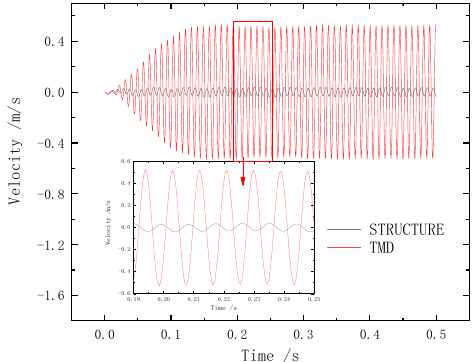
Figure 13. Comparison of structure and TMD velocity time-history curve.